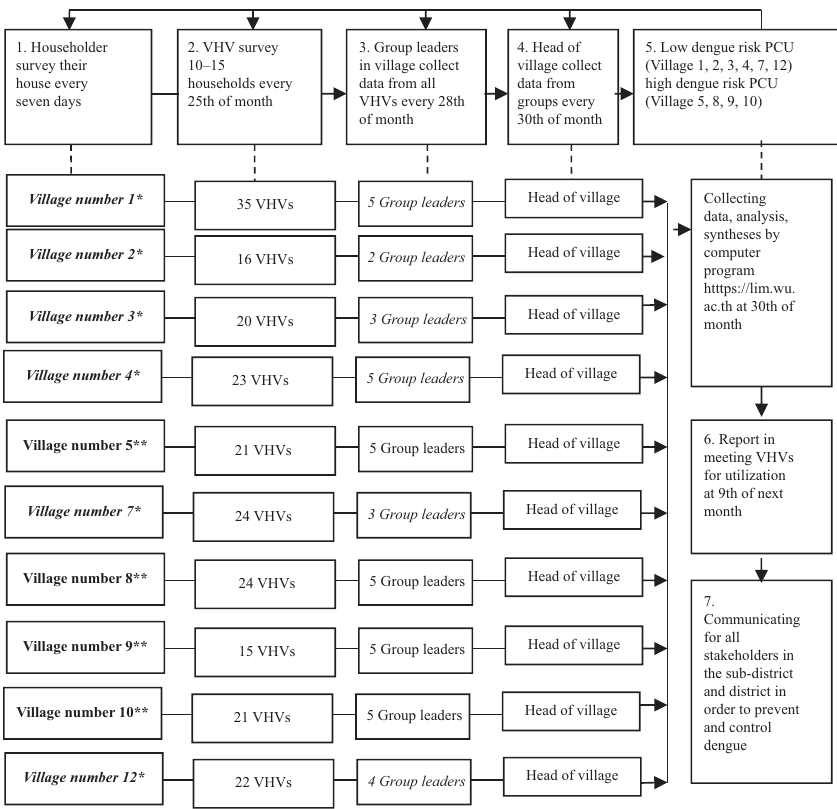
Figure 1. The larval indices surveillance system of low and high dengue risk